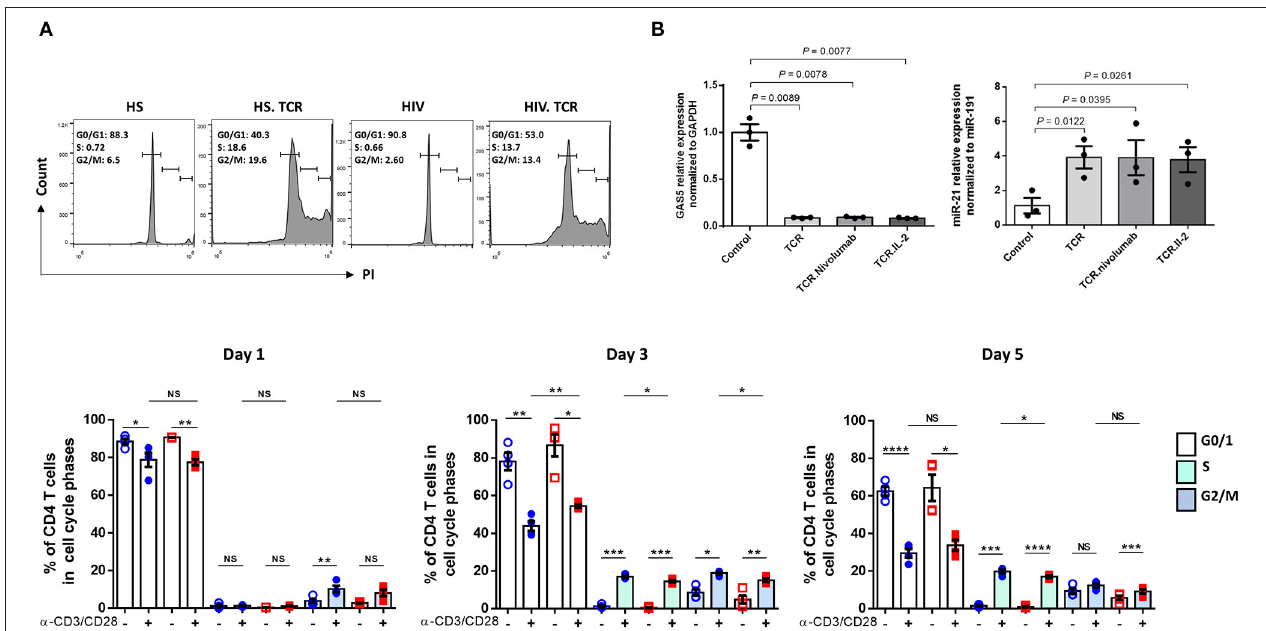
FIGURE 2 | Cell cycle progression, AGO2 expression, and effect of anti-PD1/IL-2 in TCR-stimulated CD4T cells on GAS5-miR-21 axis. (A) Cell cycle progression in CD4T cells from HS and PLHIV following TCR stimulation at day 1, 3, and 5 measured by PI flow cytometric analysis ( n = 4). Representative histogram of cell cycle phases of CD4T cells from HS and PLHIV with and without TCR stimulation at day 3 are shown above and summary data at day 1, 3, 5 are shown below. (B) Relative expression of GAS5 and miR-21 in CD4T cells from HS and PLHIV following anti-PD1 and IL-2 treatments for 24h, determined by RT-qPCR ( n = 3). n.s, P > 0.05; * P ≤ 0.05; ** P ≤ 0.01; *** P ≤ 0.001; **** P ≤